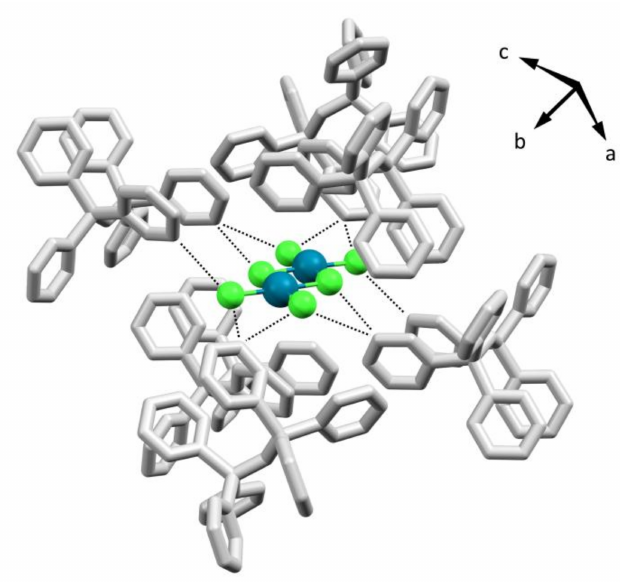
Figure 3. Crystal packing of 2 showing the six cationic molecules (capped sticks representation depicted in gray for clarity) that surrounds the hexachloropalladate